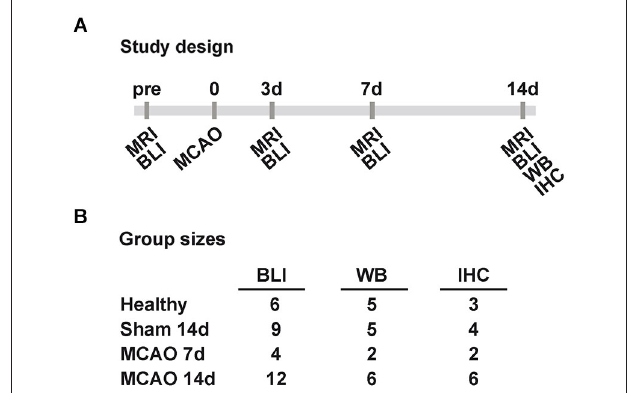
FIGURE 1 | Study design and group sizes. (A) Sham and MCAO animals were measured before (pre), and 3, 7, 14 days (3d, 7d, 14d) after 30 min MCAO with MRI and BLI. At 7d and 14d post MCAO tissue was collected for WB and IHC. (B) The displayed final group sizes as used per method and group. Excluded animals are not listed. (MCAO: middle cerebral artery occlusion, MRI: magnetic resonance imaging, BLI: bioluminescence imaging, WB: western blot, IHC: